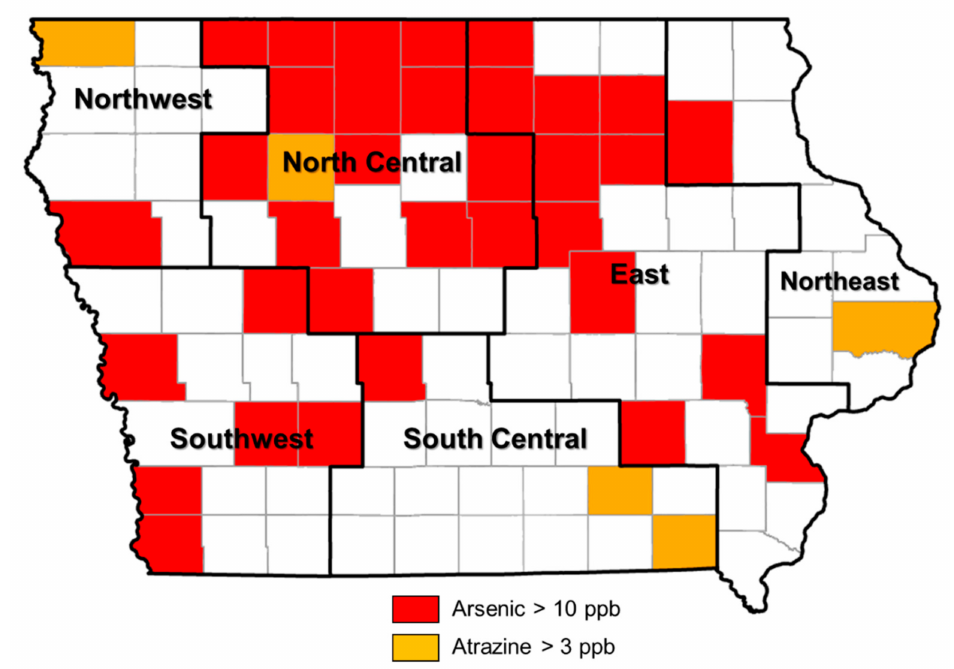
Figure 4. Spatial distribution of counties with levels of arsenic and atrazine exceeding current drinking water MCLs in private well samples,